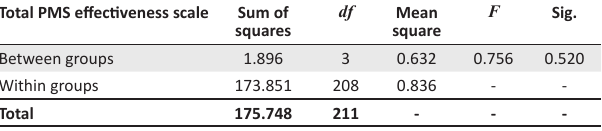
TABLE 7: One-way analysis of variance to compare the mean scores of the performance management system effectiveness between the four age groups.